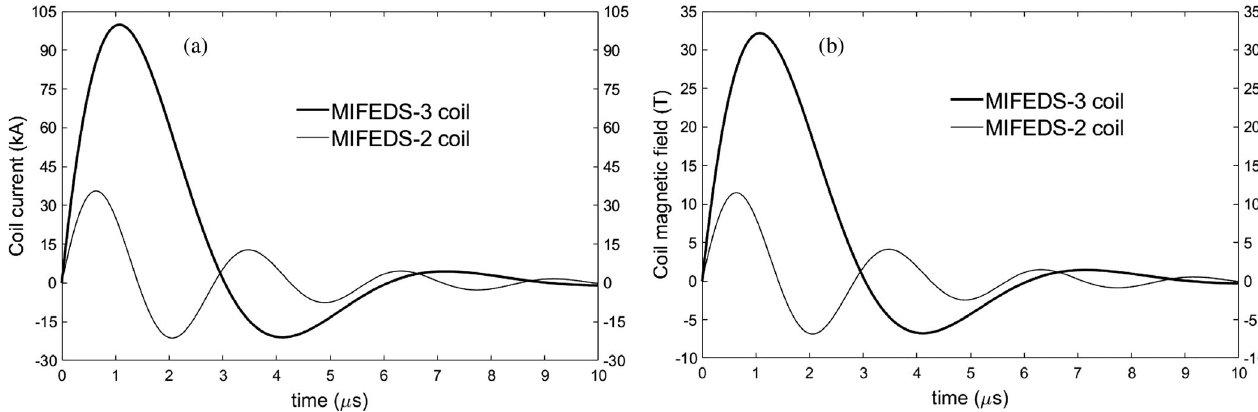
FIG. 6. Simulations of the currents and magnetic field waveforms into the 60-nH, 14 -m Ω coil. Part (a) corresponds to the MIFEDS coil current and (b) shows the peak magnetic field in the